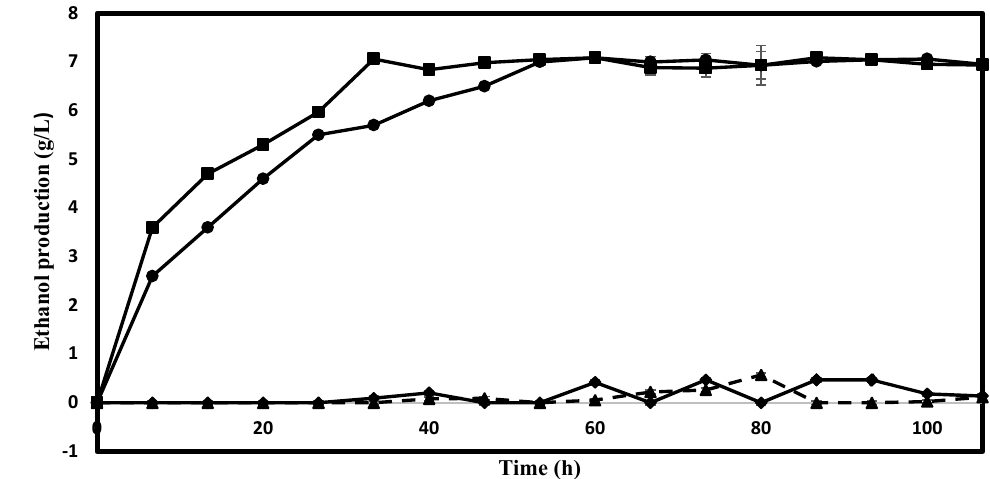
Figure 8. Time course of ethanol production from 30 g/L of different substrates by M. circinelloides. N-acetyl D-glucosamine (g/L), Chitin powder (g/L), Chitin oligosaccharides (g/L), Col- loidal chitin (g/L).